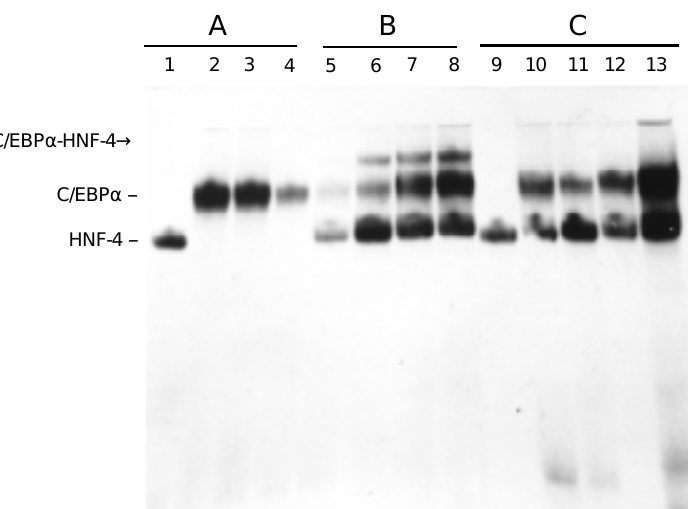
Figure 2 - Effect of the insertion of nucleotides into the -81 to -52 region of the apoB promoter. Gel electrophoresis mobility shift assays were performed with HNF-4 and C/EBP a purified by affinity chromatography and each of the following 32 P-labeled double-stranded oligonucleotides: A , Wild type probe (5'-AGGC GCCCTTTGGACCTTTTGCAATCCTGG-3') (lanes 1-4). Lane 1: 0.5 µg of HNF-4 and lanes 2-4: decreasing concentrations of C/EBP a (4, 2 and 0.8 µg, respectively). B , Probe modified by the insertion of ten nucleotides between the HNF-4 and C/EBP a motifs in the wild type sequence (5'-AGGCGCCCTTTGGAACCTTTCGGTCC TTTTGCAATCC-3') (lanes 5-8). Lane 5: 0.4 µg of C/EBP a and 0.2 µg of HNF-4. Lane 6: 0.8 µg of C/EBP a and 0.5 µg of HNF-4. Lane 7: 2 µg of C/EBP a and 0.5 µg of HNF-4. Lane 8: 4 µg of C/ EBP a and 0.5 µg of HNF-4. C , Probe modified by the insertion of a thymidine nucleotide at the -71 position of the apoB promoter (5'-AGGCGCCCTTTTGGACCTTTTGCAATCCTGG-3') (lanes 9- 13). Lane 9: 0.5 µg of HNF-4. Lane 10: 0.5 µg of HNF-4 and 1.5 µg of C/EBP a . Lane 11: 1 µg of HNF-4 and 0.8 µg of C/EBP a . Lane 12: 0.5 µg of HNF-4 and 2 µg of C/EBP a . Lane 13: 5 µg of C/ EBP a and 2 µg of HNF-4. The arrow indicates the ternary com- plexes formed by interaction between HNF-4 and C/EBP a